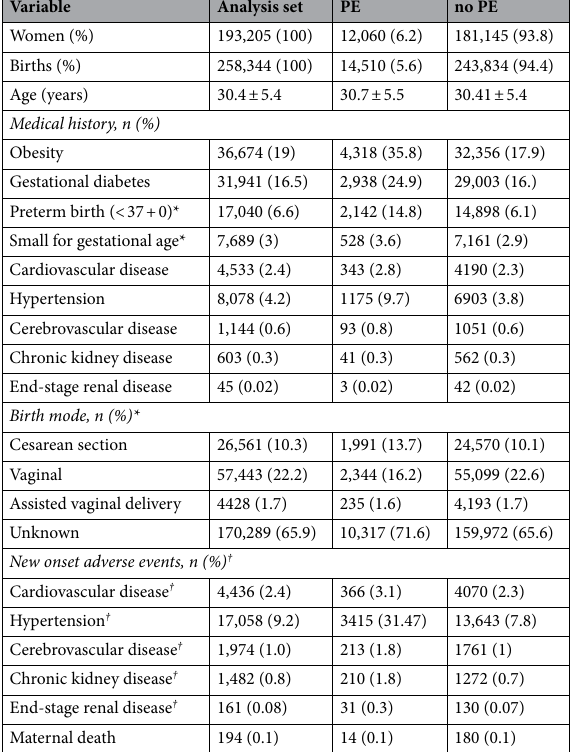
Table 1. Clinical baseline characteristics of the study cohort. Data are presented as mean ± standard deviation or absolute numbers (percentage). *Percentages refer to total number of births. † Percentages refer to total number, excluding women with preexisting diagnosis of each